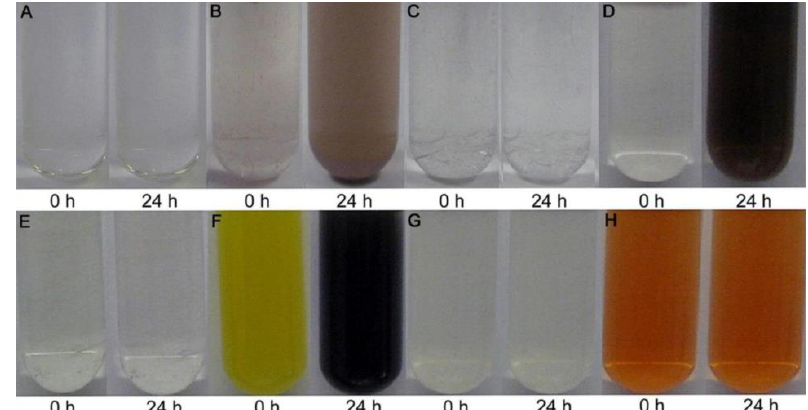
Figure 5. Reductase activity in cellular fractions. ( A ) Cell lysate of strain ER-Te-48 grown without prior exposure to K 2 TeO 3 . Similar results for T4, JF1, Se-1-2-red, and Te-2-2. ( B ) Strain ER-Te-48 lysate after cells exposure to K 2 TeO 3 . Initial darkening at 0 h is due to the trace presence of previously reduced K 2 TeO 3 from exposure prior to lysis. ( C ) Strain Te-2-2 cell lysate after K 2 TeO 3 exposure. Similar results for Se-1-2-red, T4, and JF1. ( D ) ER-Te-48 periplasmic fraction containing reductase activity following tellurite exposure. ( E ) JF1 periplasmic fraction with and without prior tellurite exposure. No reductase activity observed. Similar results for Se-1-2-red, T4, and Te-2-2. ( F ) JF1 spheroplast fraction containing reductase activity without prior exposure. T4 and Te-2-2 showed similar results. ( G ) Se-1-2-red spheroplast fraction. No reduction observed with and without prior tellurite exposure. Similar results for ER-Te-48. ( H ) T4 spheroplast lysate. No reductase activity with and without prior tellurite exposure. Similar results for JF1, Se-1-2-red, Te-2-2, and ER-Te-48. [101].